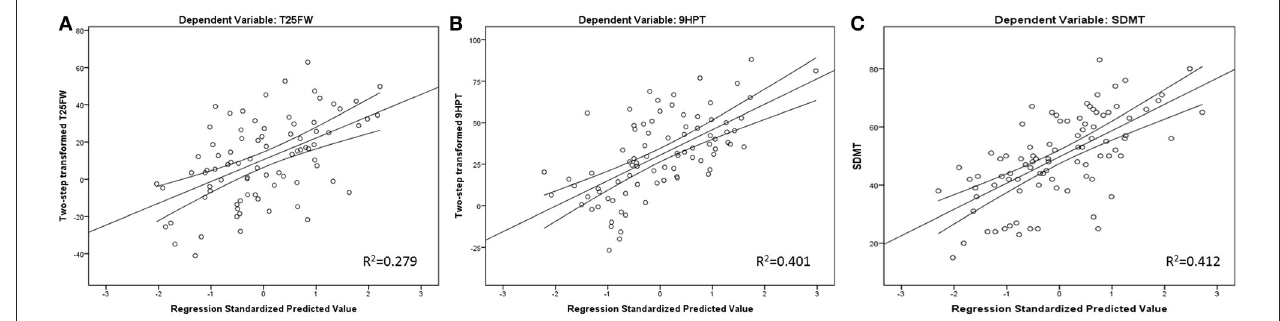
FIGURE 1 | Regression-based plots for explained T25FW (A) , 9HPT (B) , and SDMT (C) variance. Legend: 9HPT, 9 Hole peg test; T25FW, Timed 25 foot walk; SDMT, Symbol Digit Modalities Test. Both 9HPT and T25FW were normalized by fractional ranks and an inverse distribution function.